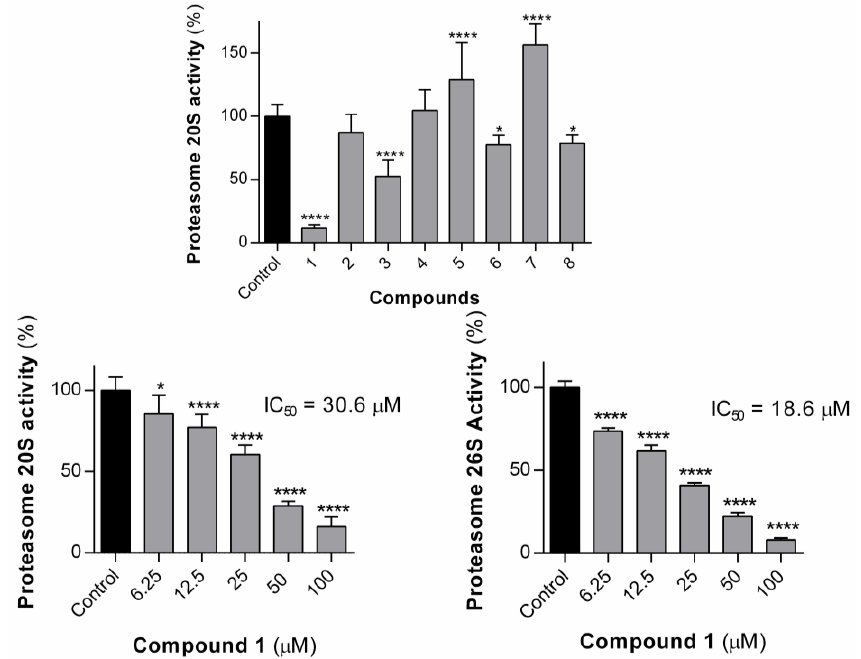
Figure 8. Proteasome 20S activity in the presence of compounds 1 – 8 at 100 µ M and dose-response graphs for compound 1 20S and 26S proteasome. Values are shown with mean ± SD. * p ≤ 0.05; **** p ≤